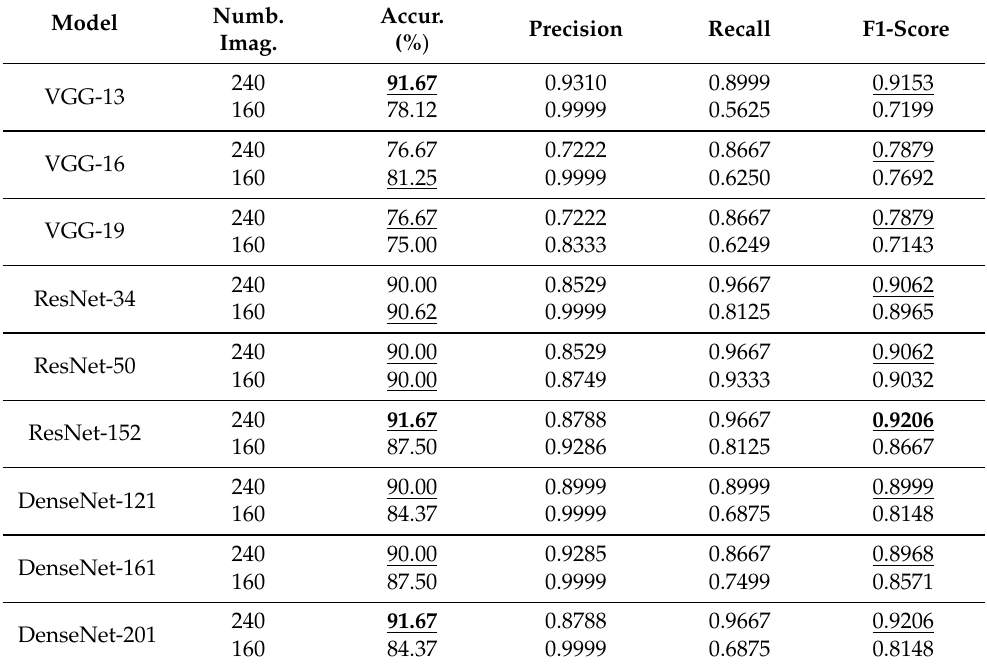
Table 2. Assessment of the database